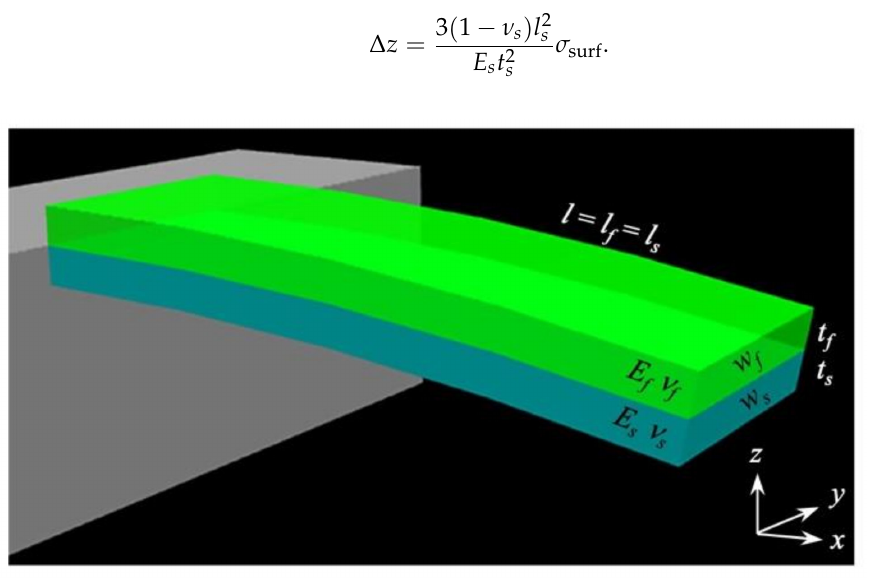
Figure 4. Schematic illustration of conventional cantilever-type nanomechanical sensors in the Cartesian coordinates. Reprinted with permission from Ref. [75]. Copyrights 2012,